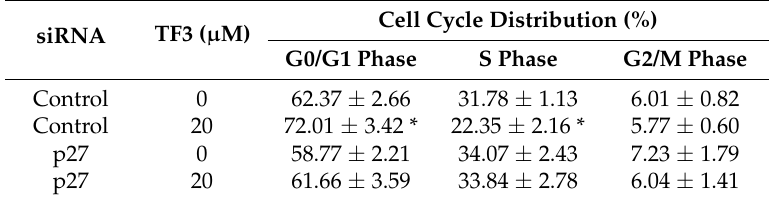
Table 2. Knockdown of p27 partially abrogated TF3-induced G0/G1 cell cycle